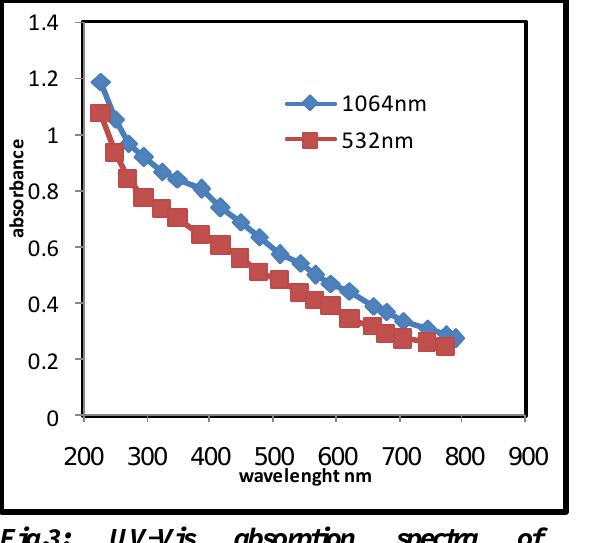
Fig.3: UV-Vis absorption spectra of nanoparticles colloid fabricated at laser wavelenght of 532 and 1064nm in water.